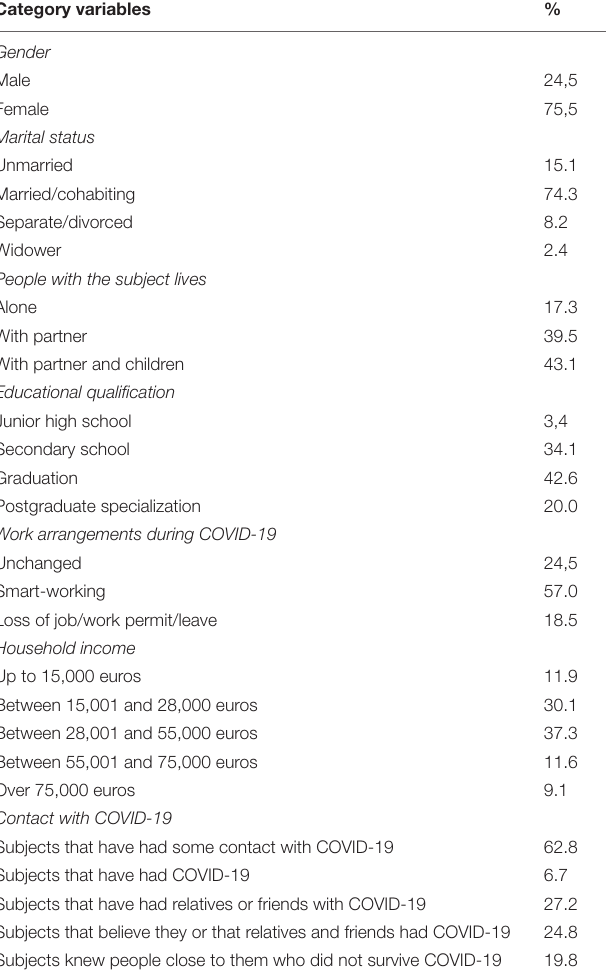
TABLE 1 | Sociodemographic characteristics of the participants ( N = 721).